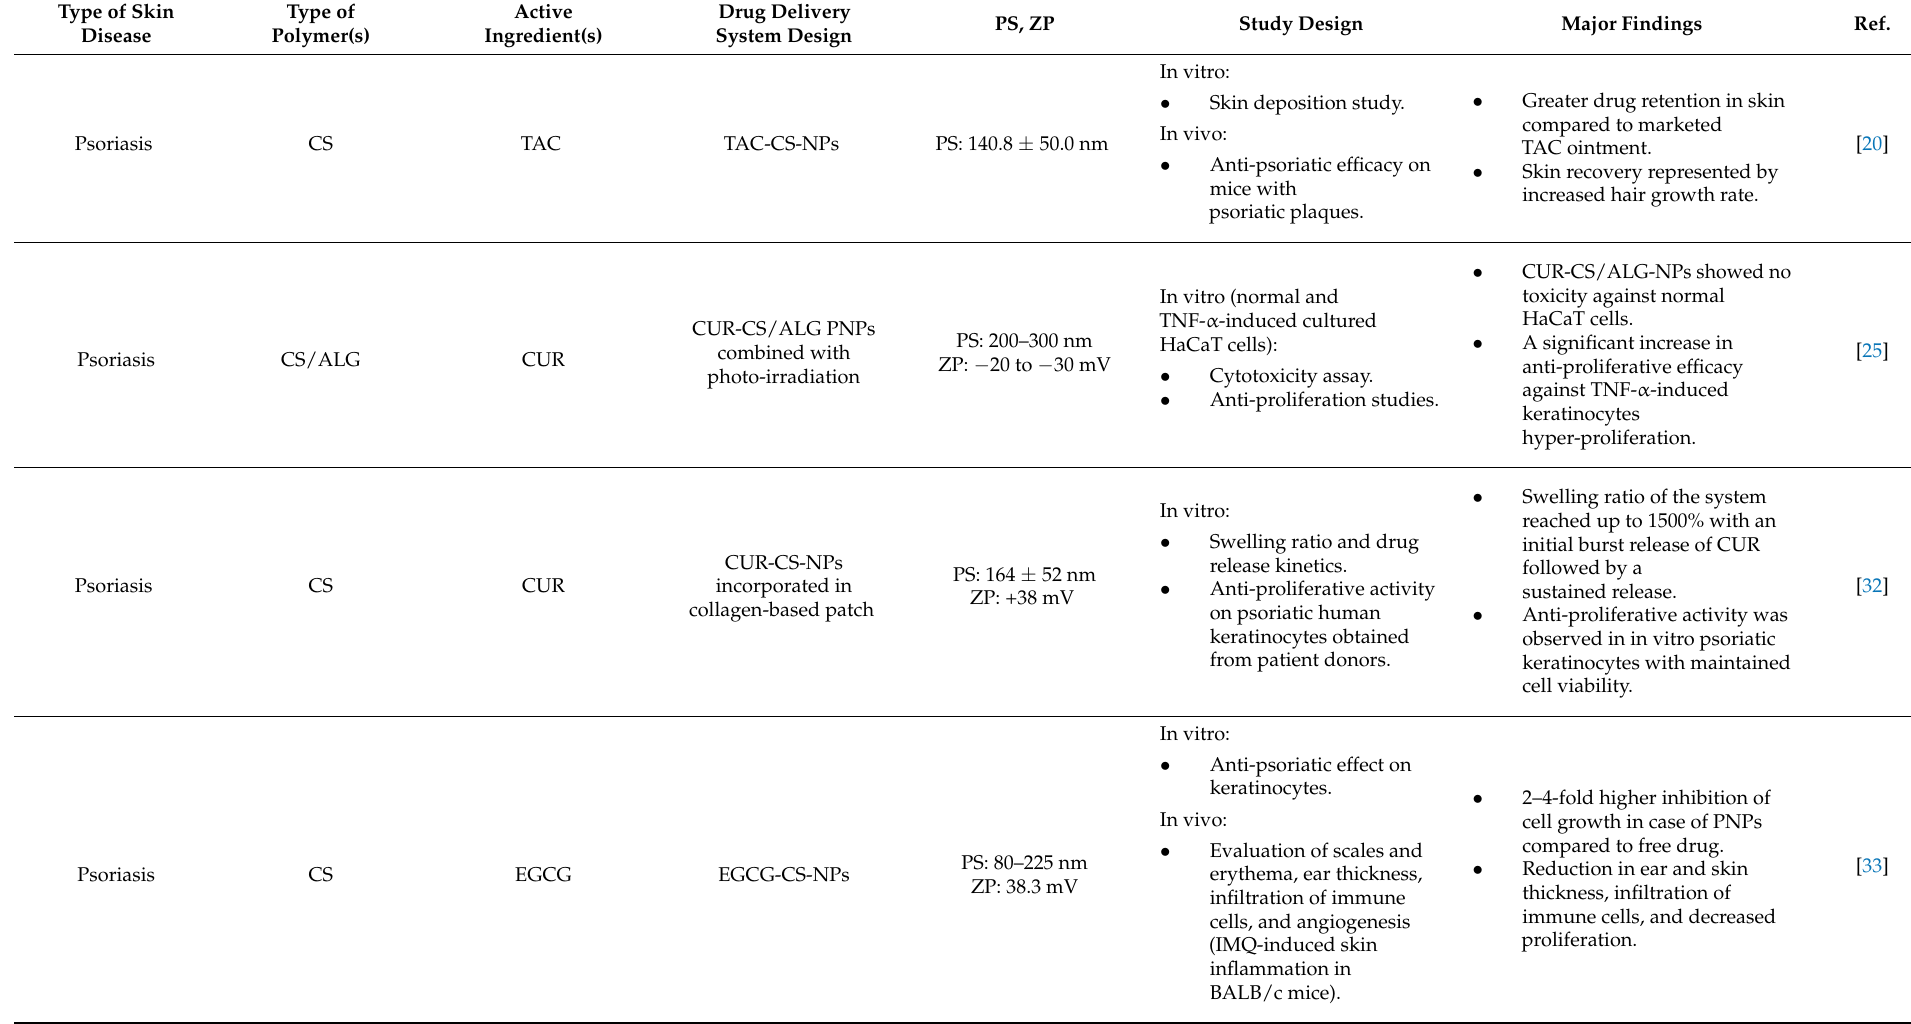
Table 1. A summary of natural polymers-based PNPs used for the treatment of different topical skin diseases. Type of Skin